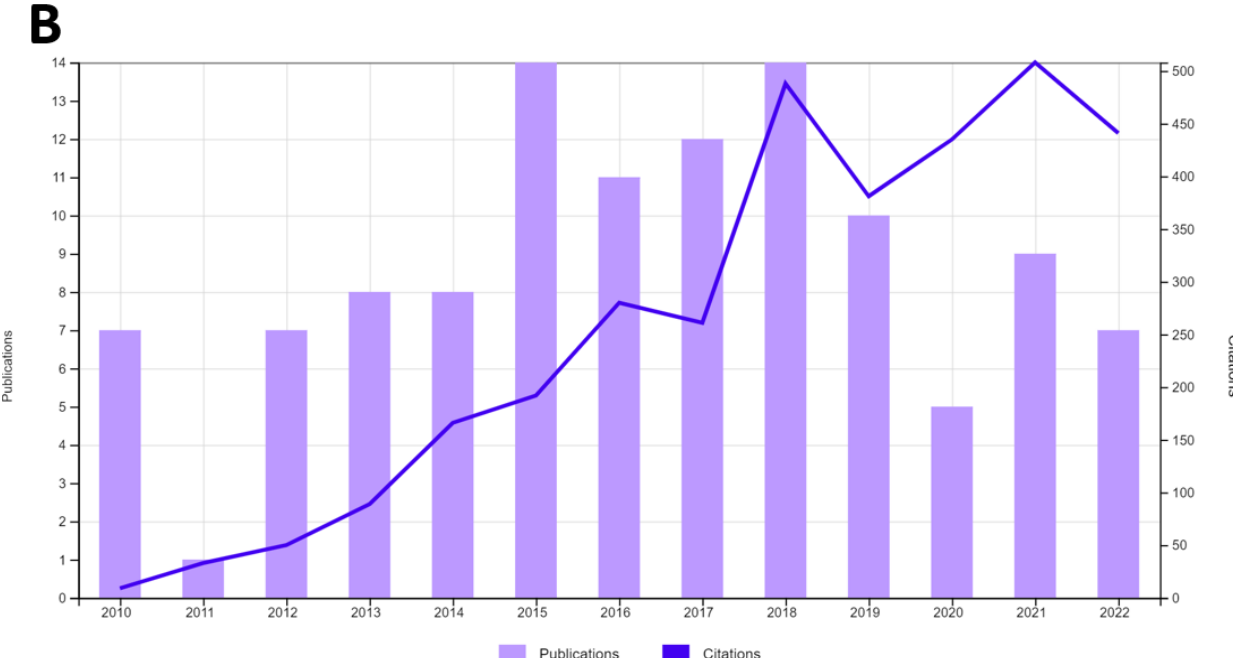
Figure 1. Number of published articles over the years that contain the following terms. ( A ) “bacteriophage p22” OR “phage p22” and ( B ) “VLP P22 OR P22 virus-like particle OR P22 nanoparticle OR P22 nanocarrier”. Research was realized through the Web of Science platform.